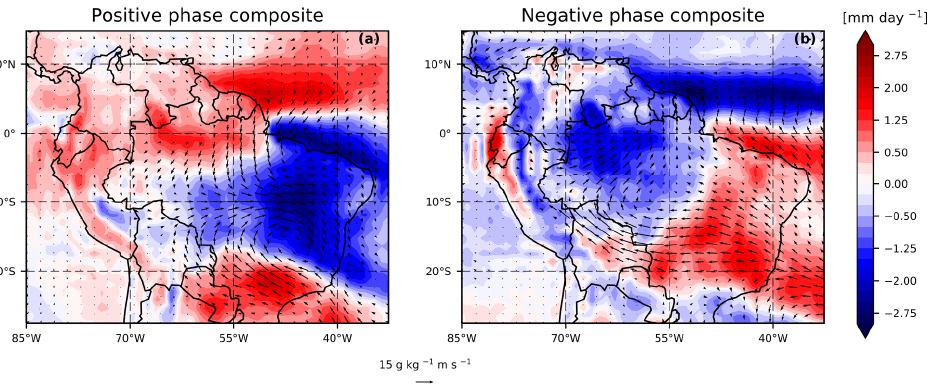
Figure 4. ( a ) DJF anomalies of the composite corresponding to the composite of the 10 years with the maximum magnitude of PC1. Arrows indicate moisture flux at 850 hPa and colors indicate vertical integral of divergence of moisture flux; ( b ) As in ( a ) but for the 10 years with the minimum magnitude of PC1. Note that blue colors indicate moisture flux convergence and red colors indicate moisture flux divergence. Anomalies are defined as the deviation from the average for the period, 1931–2010. Data from ECMWF ERA-20C